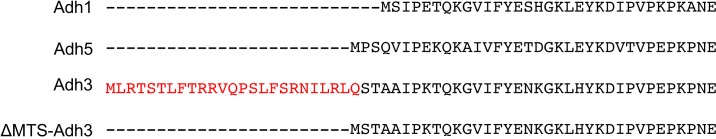
Comparison of the N-terminal amino-acid sequences of Adh1, Adn5, Adh3, and Adh3 mutants without the mitochondrial targeting sequence (ΔMTS-Adh3).Red letters indicate the predicted mitochondrial targeting sequence.